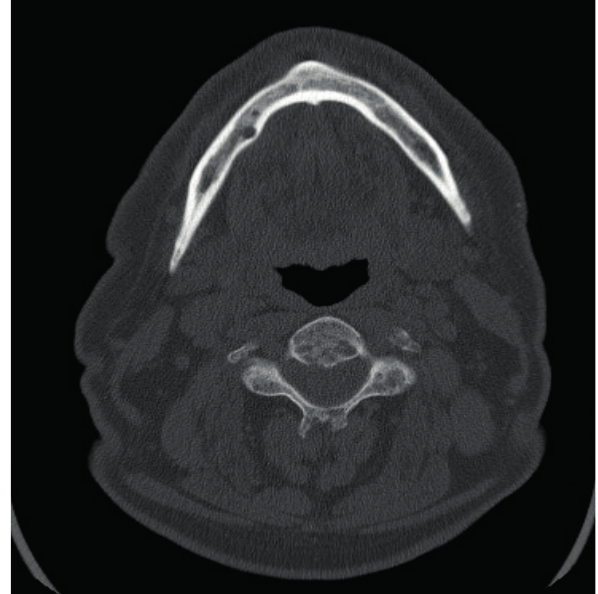
Fig. 1. The presence of osteolytic lesions in the jawbone in a patient with multiple myeloma using low-dose computed to-